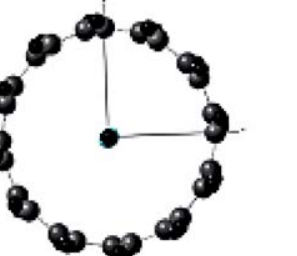
Figure 1. HX studied orientations inside SWNT a) parallel to the nanotube axis noted HX(//)@CNT(n,n) b) perpendicular to the nantotube axis noted HX( ^